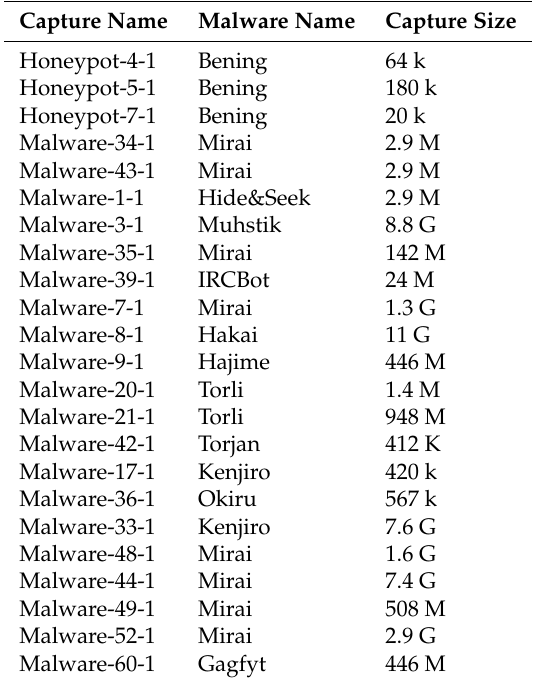
Table 4. IoT-23 datasets (capture names, malware types, and sizes).